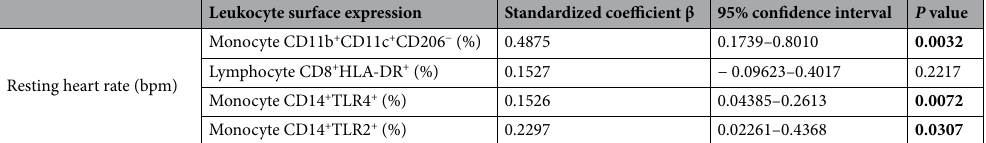
Table 4. Multiple linear regression analysis: RHR as a dependent variable, relative to monocyte surface markers. Bold values denote statistical